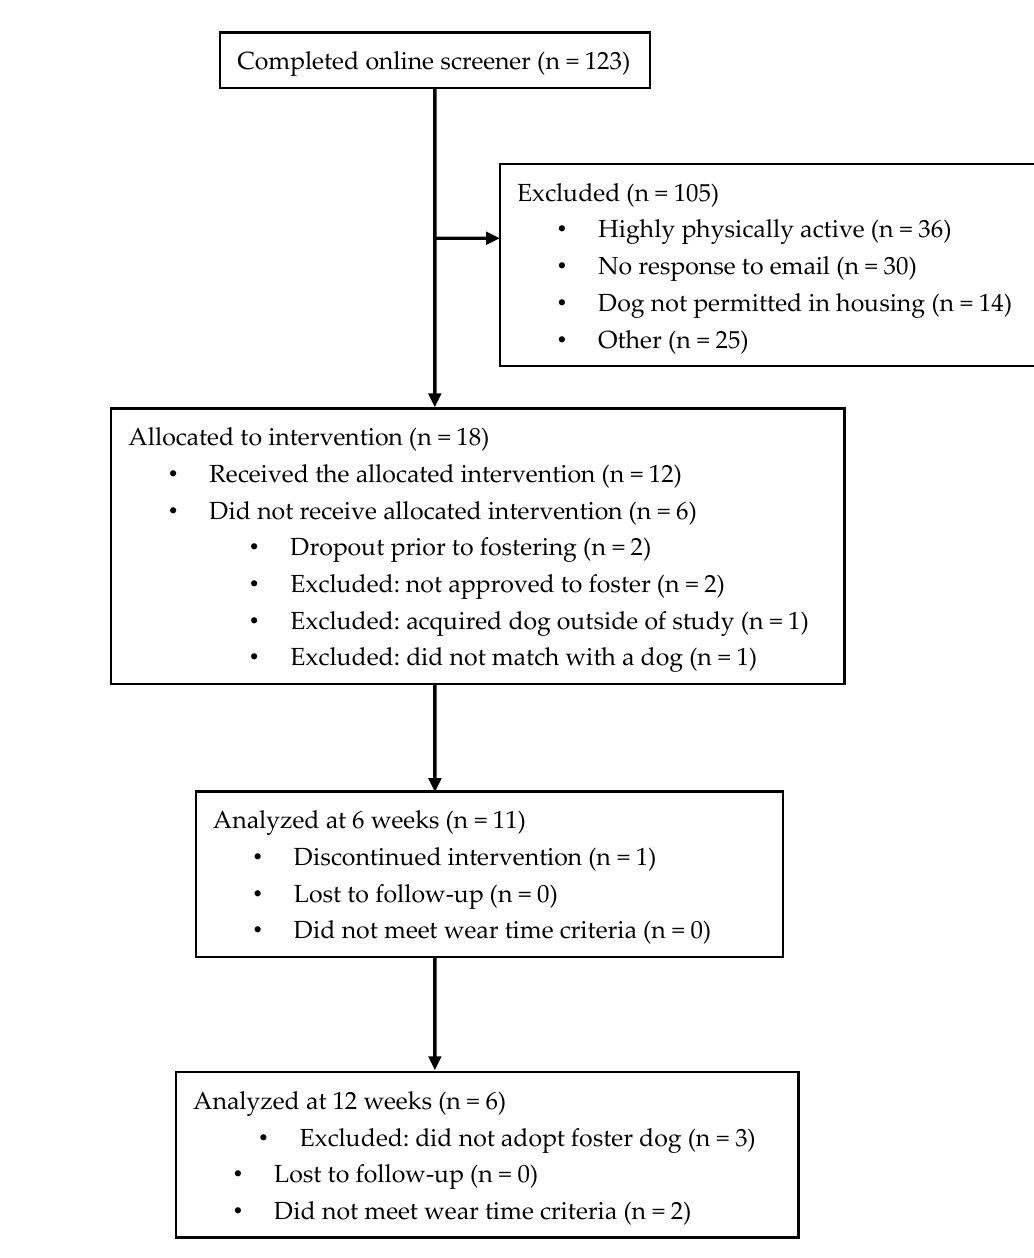
Figure 1. BuddyStudy flow chart.